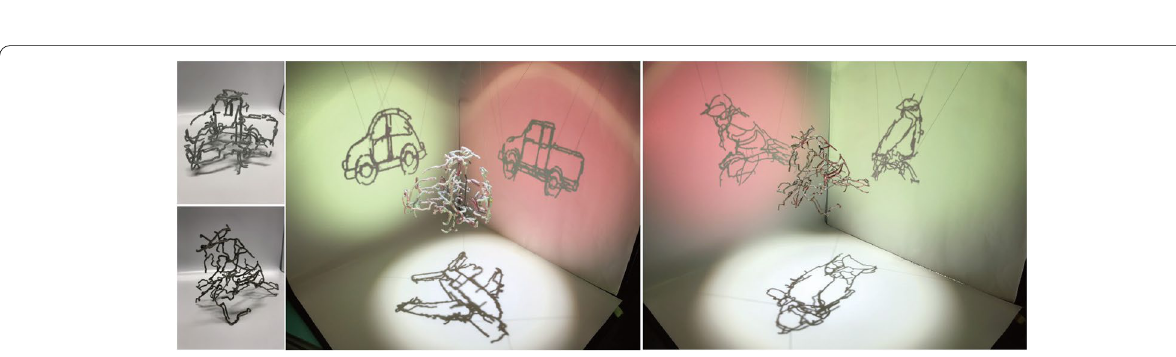
Fig. 2 Two results generated by the method of Hsiao et